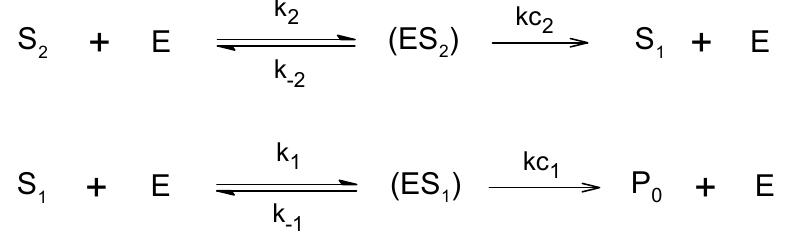
Scheme 1. Enzymatic reaction mechanism with two sequential Michaelis-Menten steps.